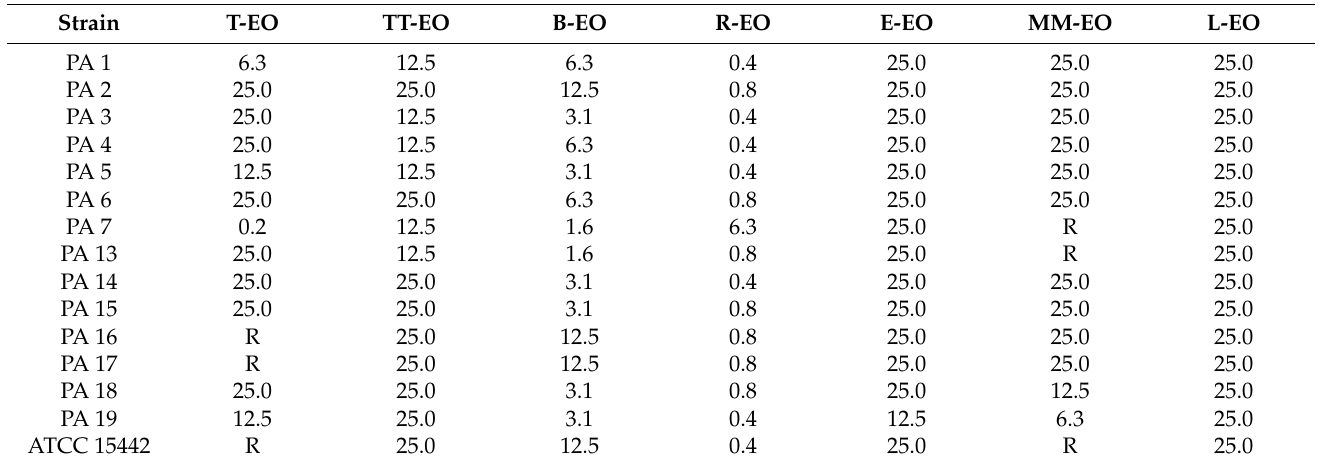
Table 3. Minimal inhibitory concentration (%) ( v / v ) of emulsified EOs in their liquid forms against P. aeruginosa clinical (PA 1–7, PA 13–19) and the reference (ATCC 15442) strains assessed with the microdilution method. T-EO, thyme oil; TT-EO, tea tree oil; B-EO, basil oil; R-EO, rosemary oil; E-EO, eucalyptus oil; MM-EO, menthol mint oil; L-EO, lavender oil. R symbols indicate EOs where the minimal inhibitory concentration values were not reached in the highest concentration (25.0% ( v / v )) of applied